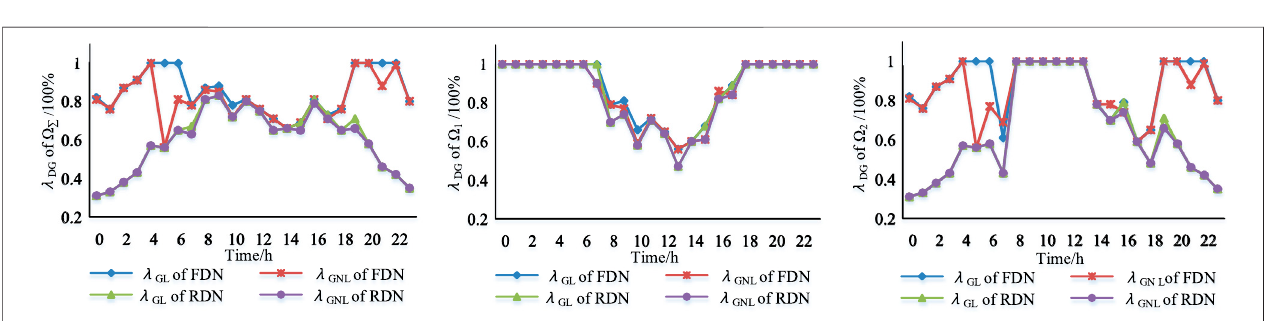
Frontiers in Energy Research |